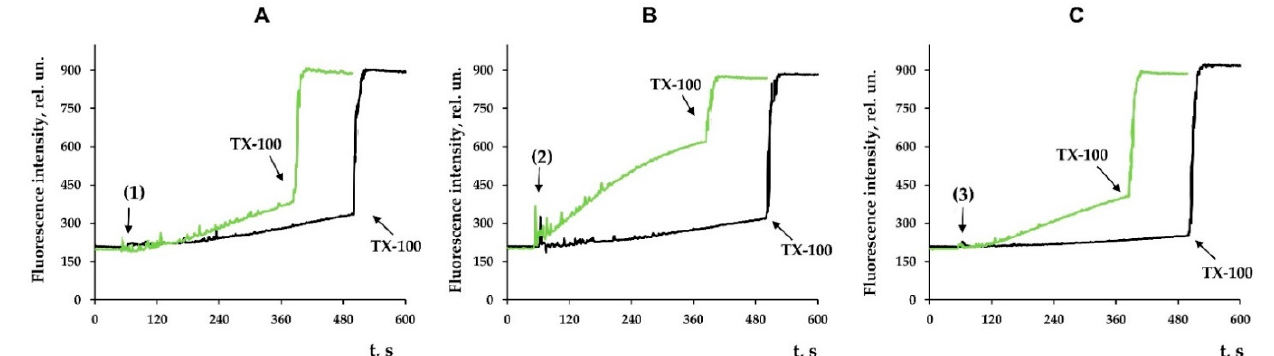
Figure 8. Effects of modified levopimaric acid diene adducts on SRB release from lecithin liposomes. The incubation medium contained 10 mM Tris/HCl (pH 7.5), 50 µ M EGTA, and 40 mM KCl. Addi- tions: 10 µ M ( black lines ) and 30 µ M ( green lines ) of tested compounds 1 ( A ), 2 ( B ) and 3 ( C ). Other additions: 0.1% Triton X-100. The picture shows typical curves recorded with the same sample during the same experiment. Similar results were observed in two other independent